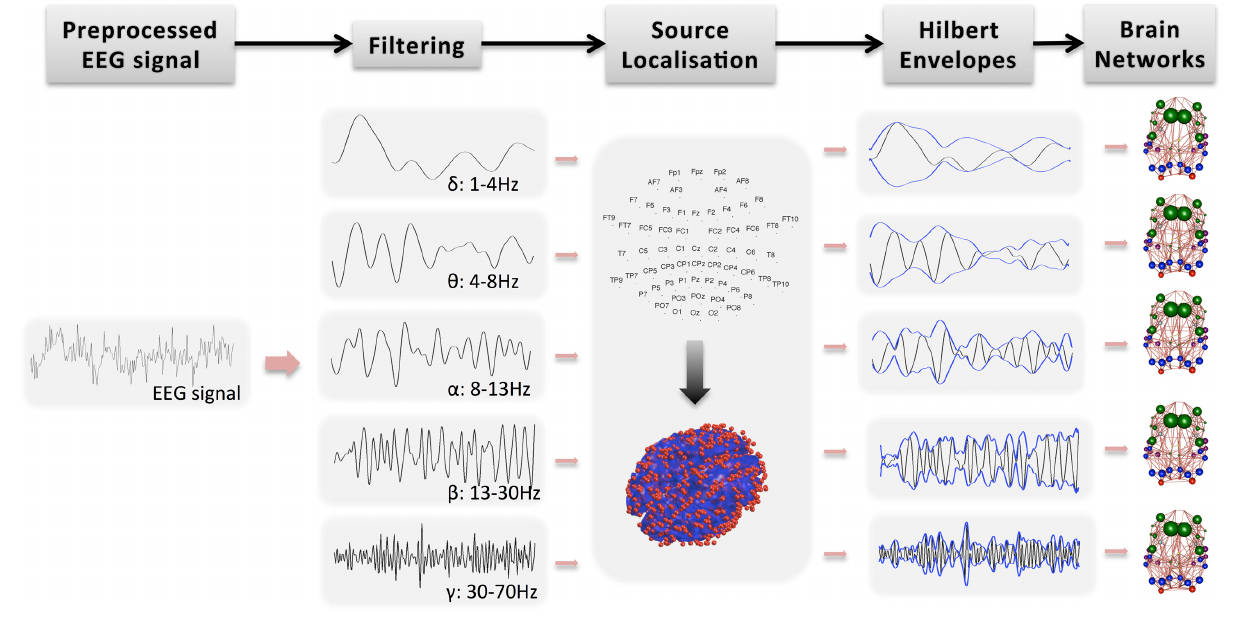
FIGURE 1 | Main steps toward deriving functional brain networks from the preprocessed EEG signal.